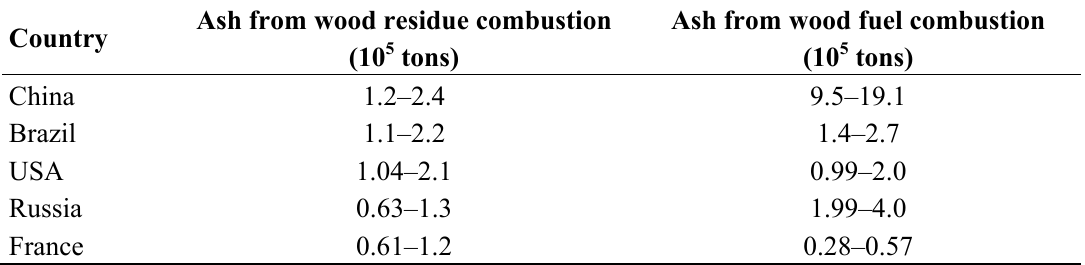
Table 3. Estimate of potential ranges of net ash production based on complete